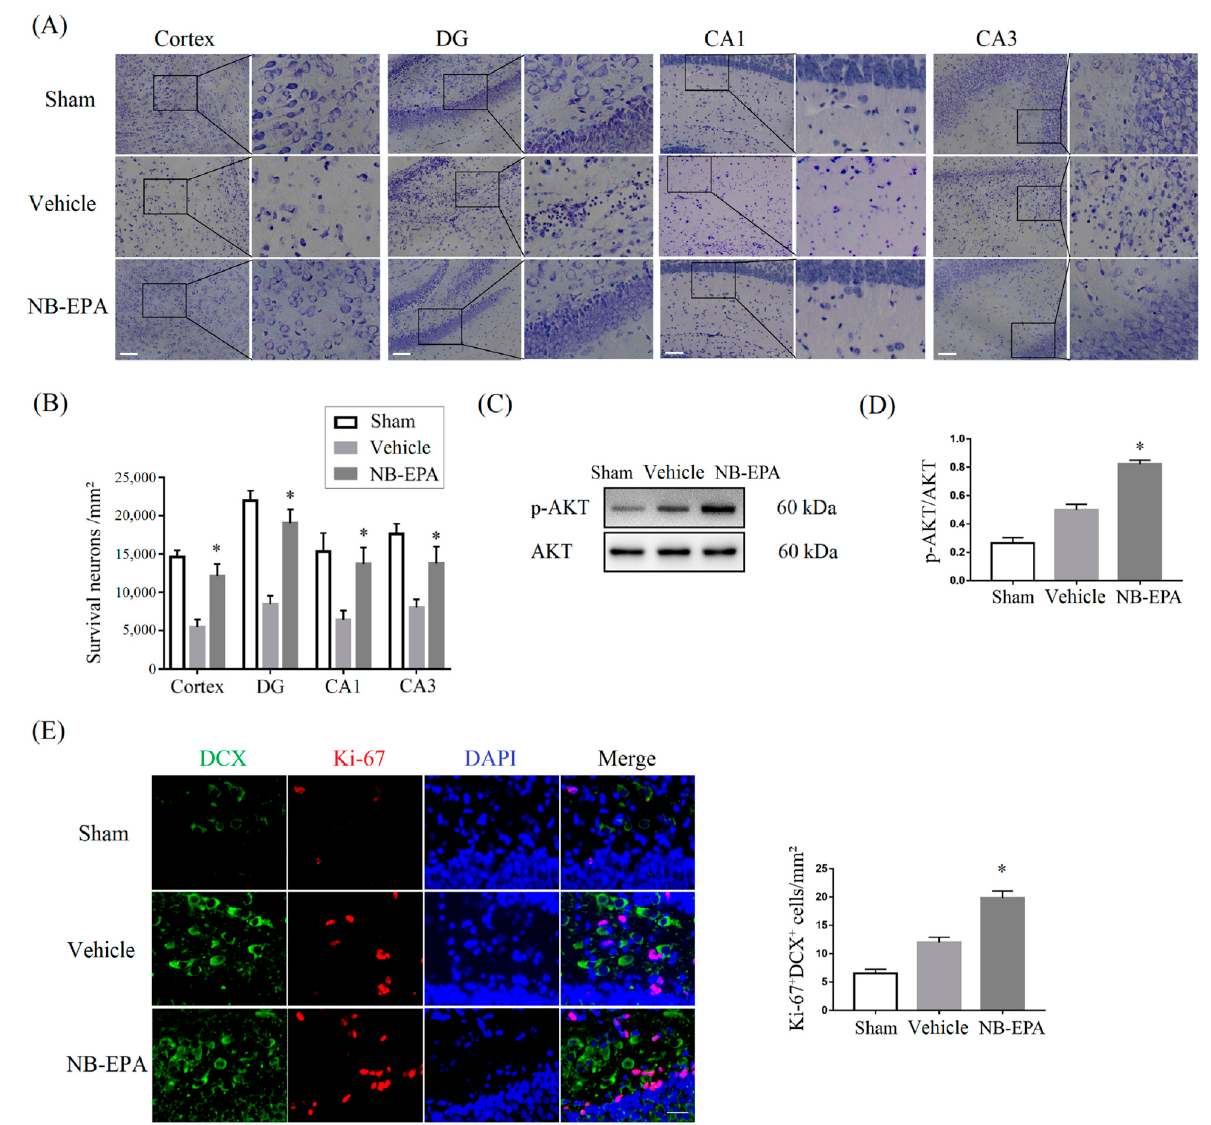
Figure 4. NB-EPA improves the neuronal survival and proliferation in neonatal mice after HI brain injury. ( A ) Representative photographs of Nissl staining in the cortex, hippocampus DG, CA1 and CA3 regions from every group of mice at 7 days post-HI (Scale bar, 75 μ m). ( B ) Statistical analysis of the number of neurons is shown in ( A ). ( C ) Representative Western blot images of p-AKT and AKT from every group of mice at 7 days after HI. ( D ) Densitometric analysis of data is shown in ( C ). ( E ) Representative images of DCX (green) and Ki-67 (red) from every group of mice at 7 days after HI (left, Scale bar, 25 µ m) in hippocampus DG regions; quantification of DCX and Ki-67 dual-labeled cells at 7 days post-HI (right). Data are mean ± SEM ( n = 8 per group). * p < 0.05 compared to vehicle.